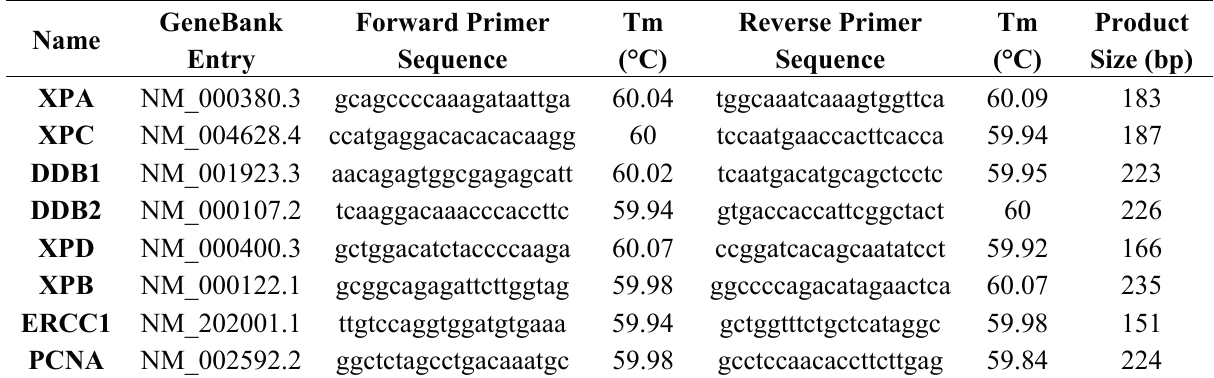
Table 1. Primer sets used for real time quantitative